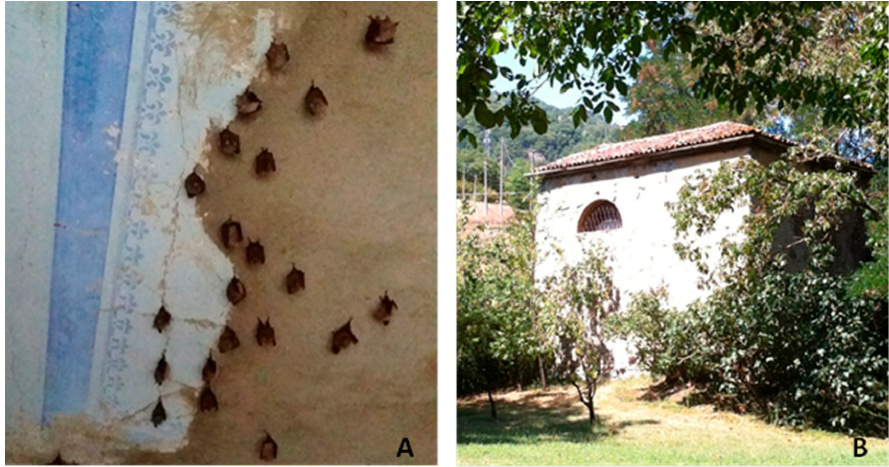
Figure 4. ( A ) Reproductive colony of lesser horseshoe bats ( Rhinolophus hipposideros ) sampled in the study and ( B ) its building